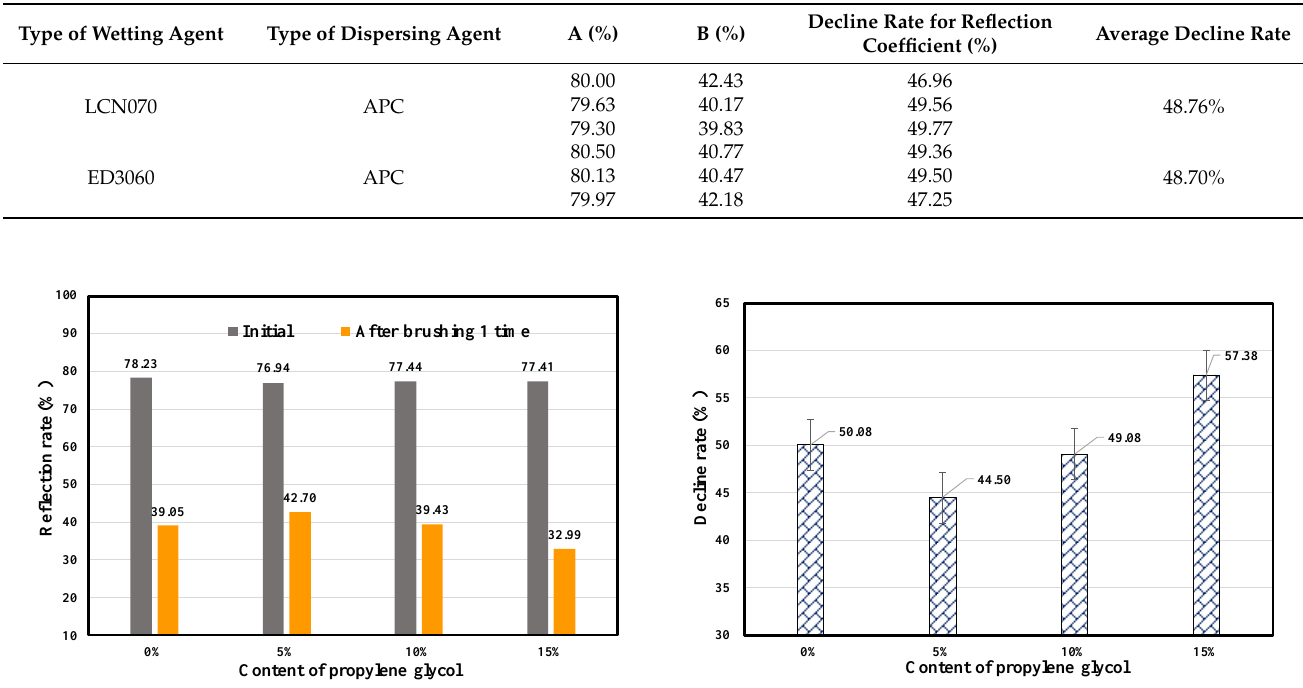
Table 12. The effects of wetting and dispersing agents on stain resistance of paints.